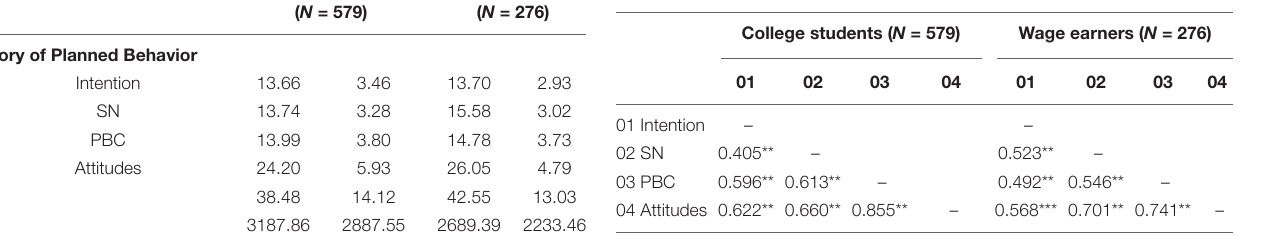
TABLE 2 | Correlations between attitudes, subjective norms (SN), perceived behavioral control (PBC), and physical activity